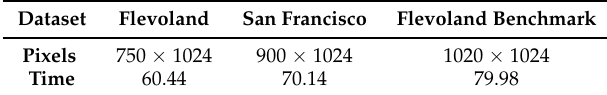
Table 4. Execution time (in seconds) of extracting features via FCN-8s for the three experimental data sets.